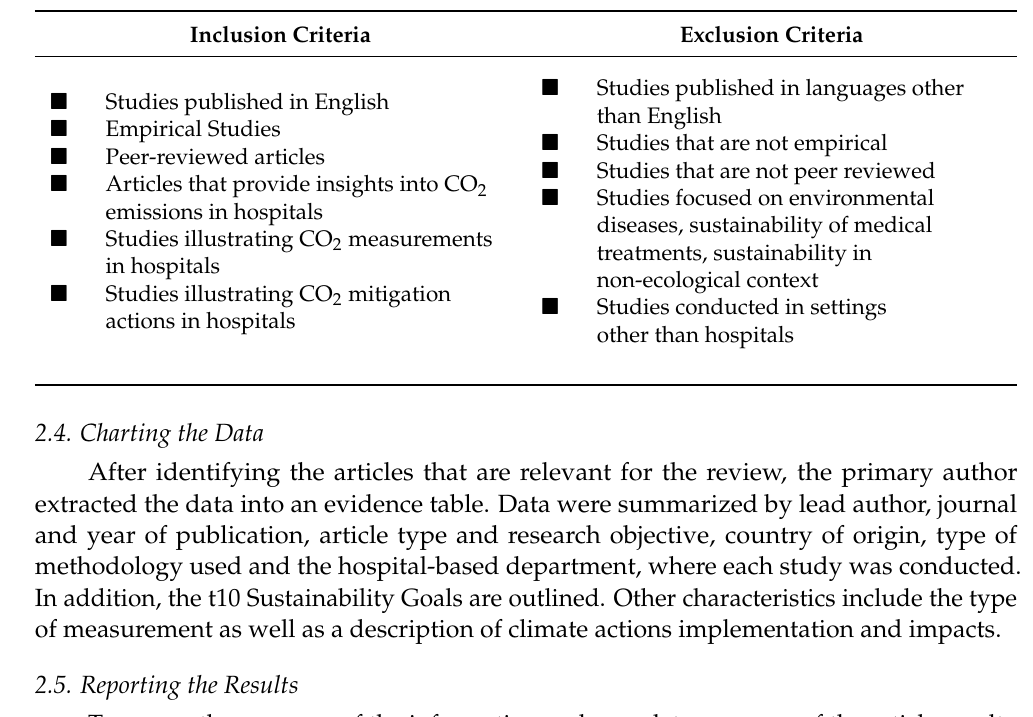
Figure 1. Preferred Reporting Items for Systematic Reviews and Meta-Analyses (PRISMA) flow diagram for articles identified, screened and included in the review. Table 2. Inclusion and exclusion criteria for scoping review .